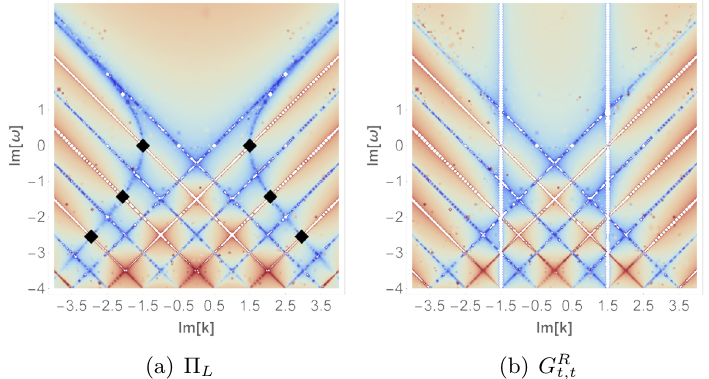
in eq. (5.1) when d = 5 , ∆ = 4 . The right t,t